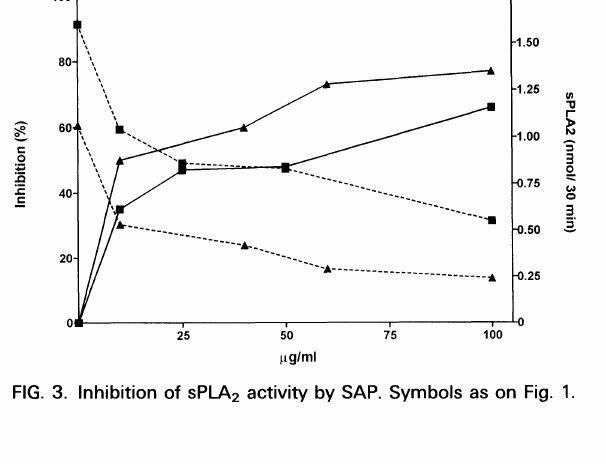
FIG. 3. Inhibition of sP2 activity by SAP. Symbols as on Fig. 1.